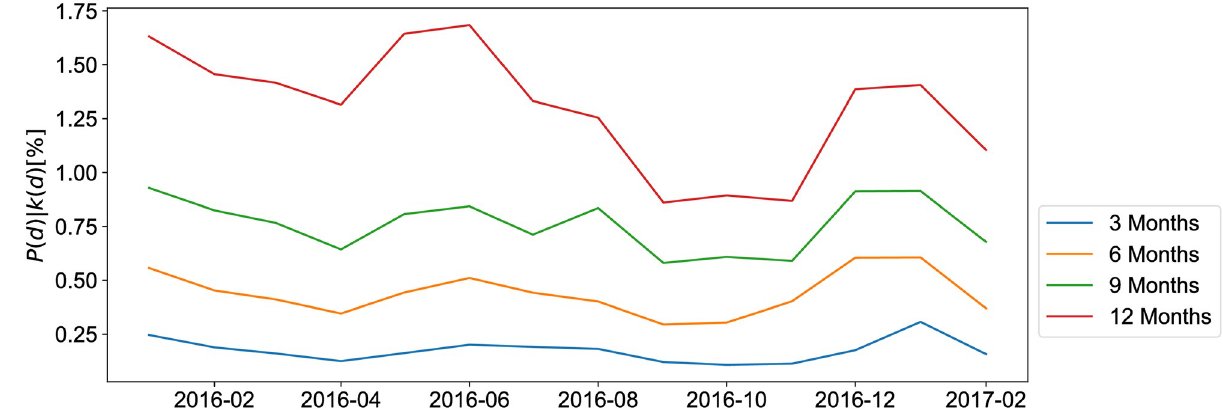
Fig 5. Percentage of adjacent nodes of insolvent firms at time t that experienced a default δ months later (for δ 2 {3, 6, 9, 12}).